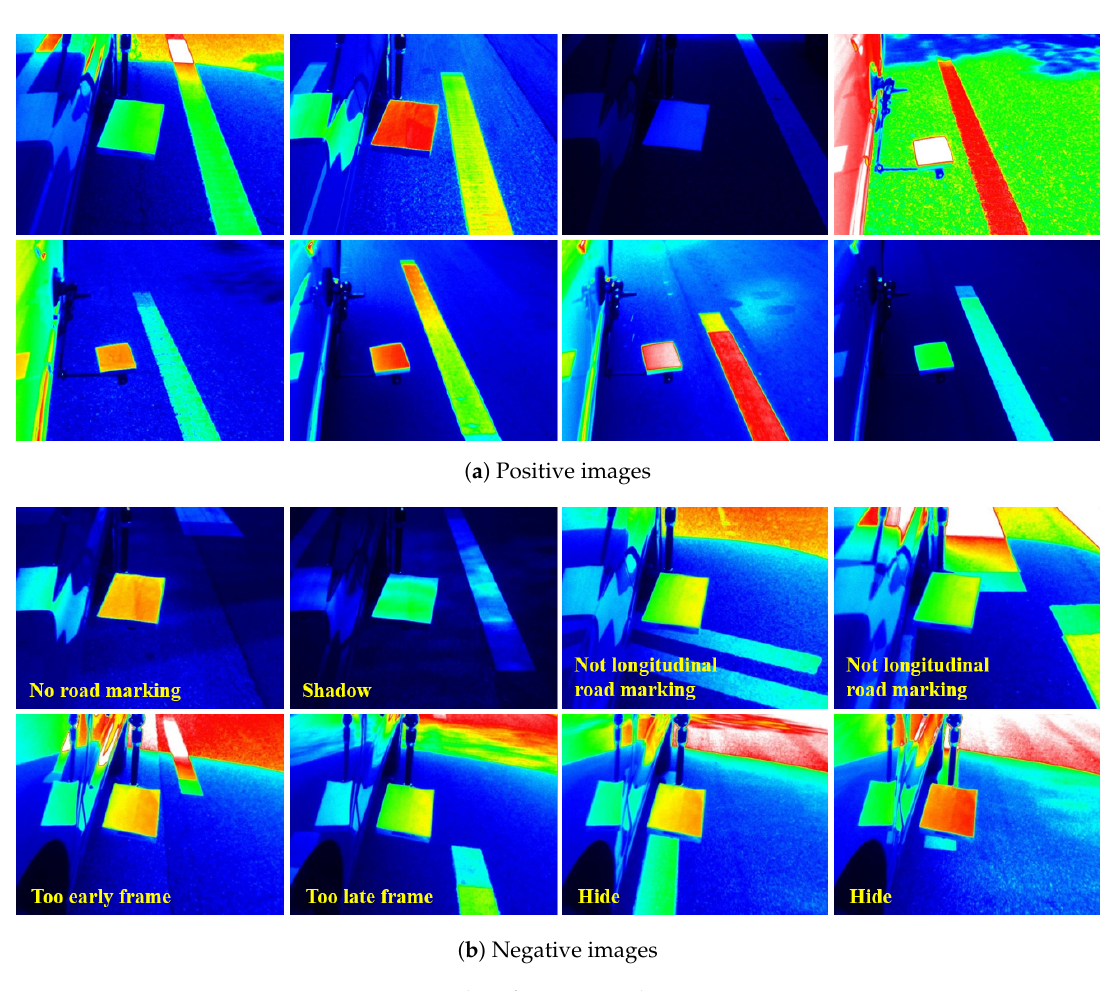
Figure 4. Examples of positive and negative images.